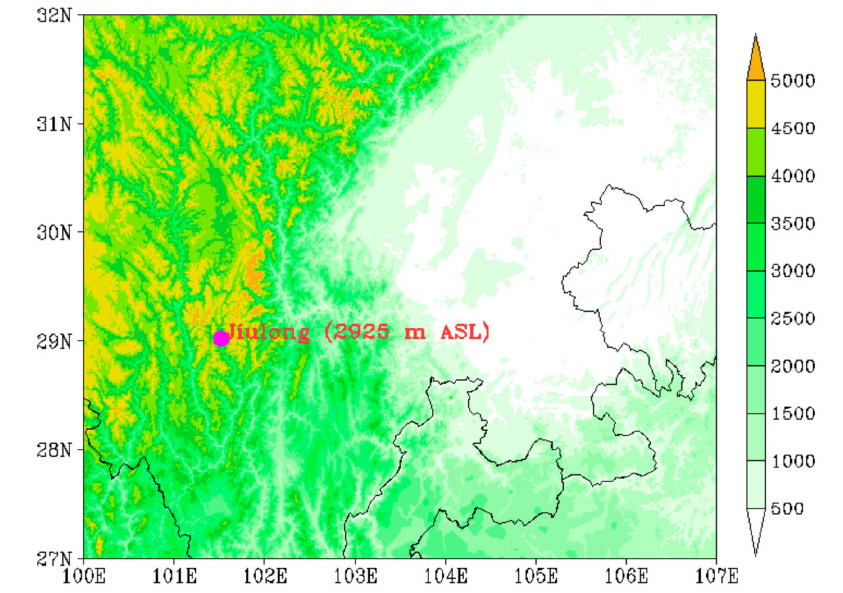
Figure 1. Location of the Jiulong station and its surrounding